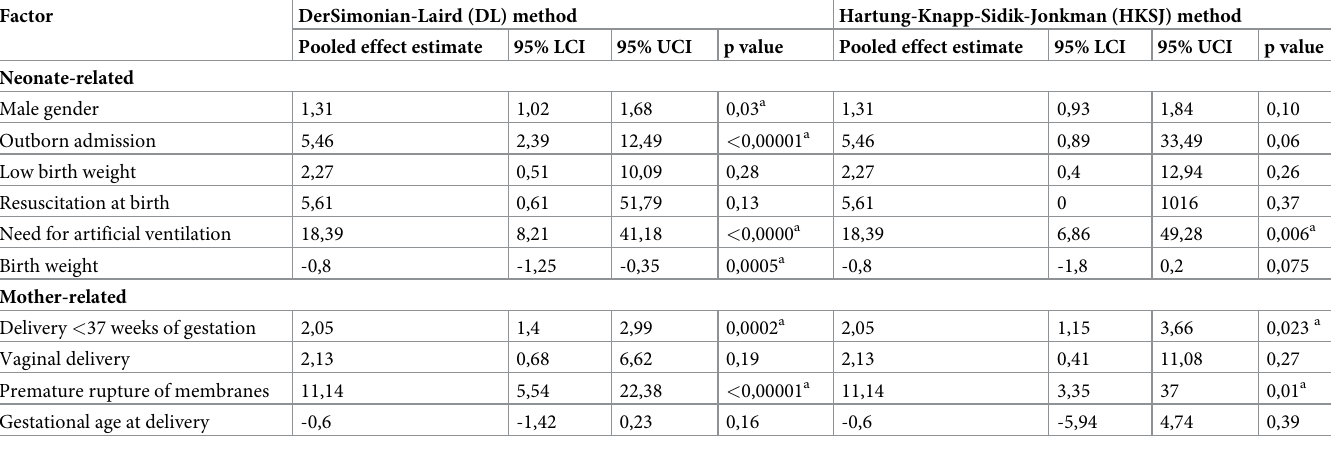
Table 3. Results of random effects meta-analysis using DerSimonian-Laird method and Hartung-Knapp-Sidik-Jonkman methods.